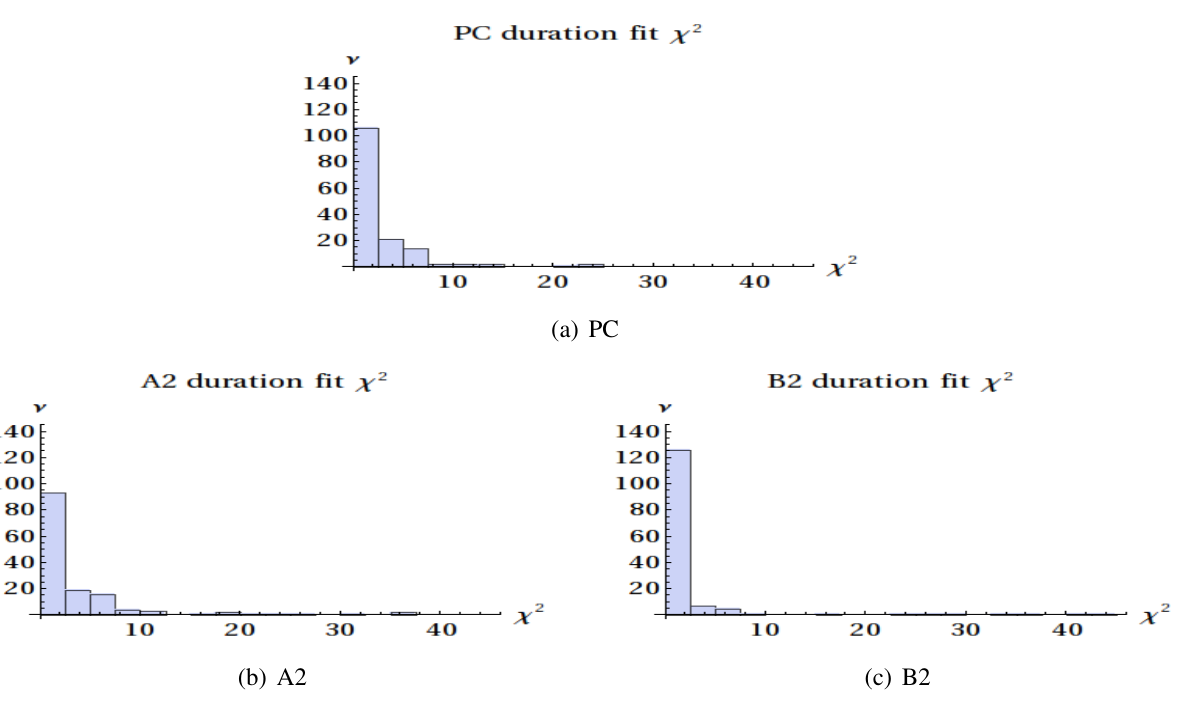
Figure 6. Distributions of the values of χ 2 variables calculated in the evaluation of the goodness of fit